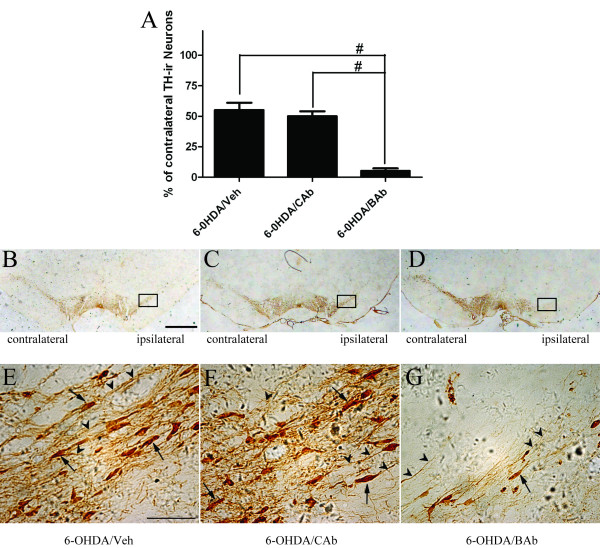
Neurodegeneration is exacerbated in the SN of hemi-parkinsonian rats. Animals (5 rats per groups) were sacrificed at 21-day post 6-OHDA injection to characterize and quantify loss of dopaminergic neurons in whole SN. (B-G) Representative sections (~24 sections per rat) of SN were immunostained with antibodies against tyrosine hydroxylase (TH). (B,E) SN of 6-OHDA/Veh group, (C,F) SN of 6-OHDA/CAb group, (D,G) SN of 6-OHDA/BAb group. The bottom photos (E-G) are higher magnifications of the cells in black rectangles of ipsilateral SN in the upper photos (B-D). Scale bar: 1 mm (B-D); scale bar: 50 μm (E-G). Arrows: neurons; arrowheads: fibers. (A) Stereological cell counts of total TH-ir neurons on the ipsilateral side of the SN are shown as a percentage of the cells on the contralateral side (n = 5/group, # P < 0.0001). All the results were obtained in a two-blinded procedure. No significant difference was found between the group treated with 6-OHDA/Veh and the group treated with 6-OHDA/CAb (P = 0.5108). Data are presented as mean ± S.E.M.